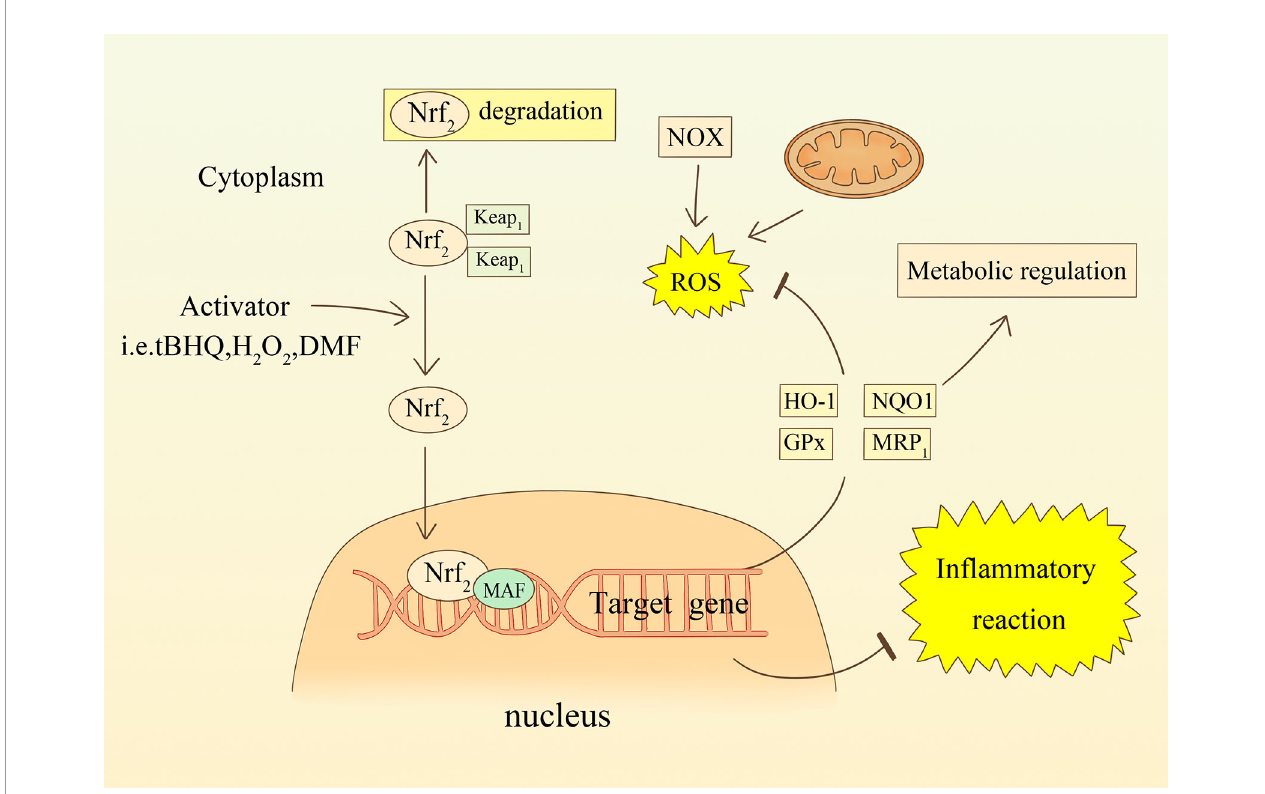
FIGURE 3 | The relationship between oxidative stress and the Nrf2 signaling pathway in astrocytes. ROS or compounds stimulate Nrf2 transcription into the nucleus and participate in the transcription of target genes. increased synthesis of enzymes such as HO-1, NQO1, GPx, and MRP1 counteract oxidative stress and regulate metabolism. Nrf2 is also involved in regulating in fl ammatory